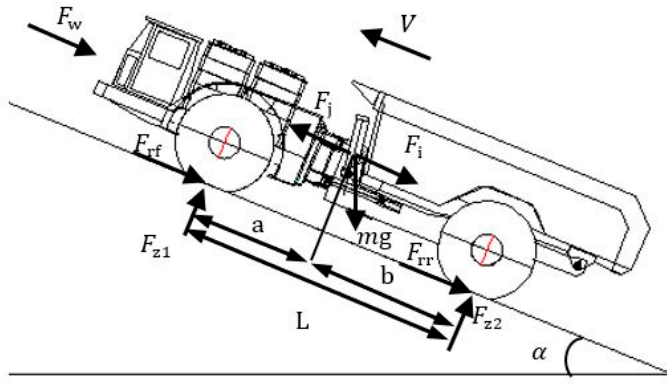
Figure 4. Vehicle force diagram.